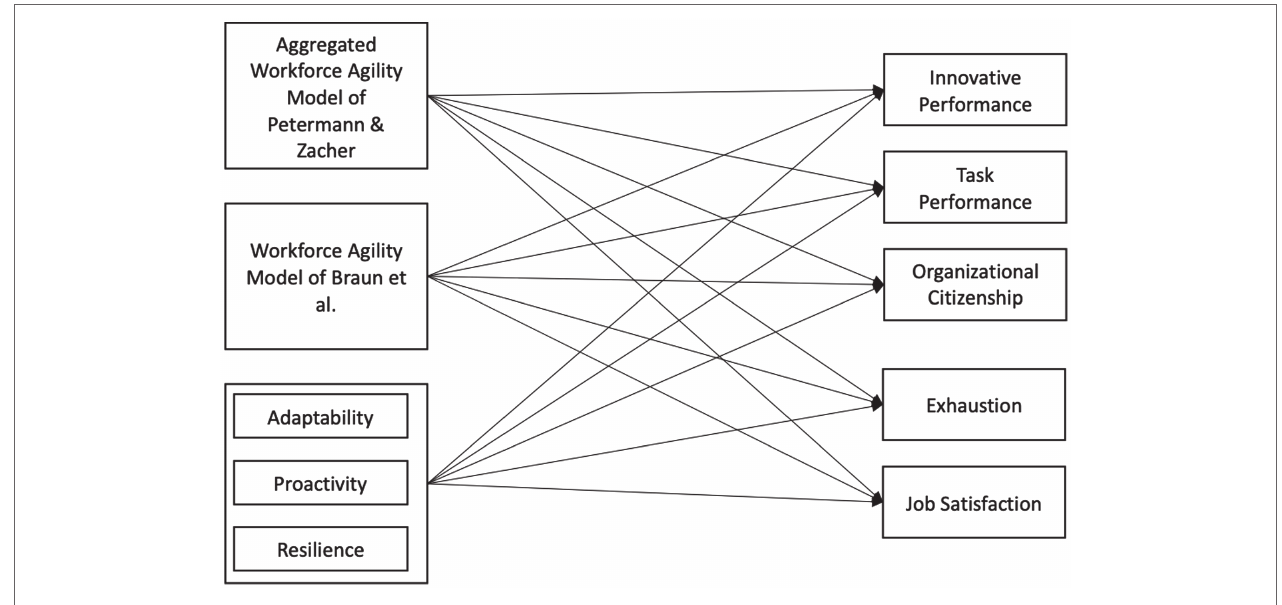
FIGURE 1 | Research model for sample